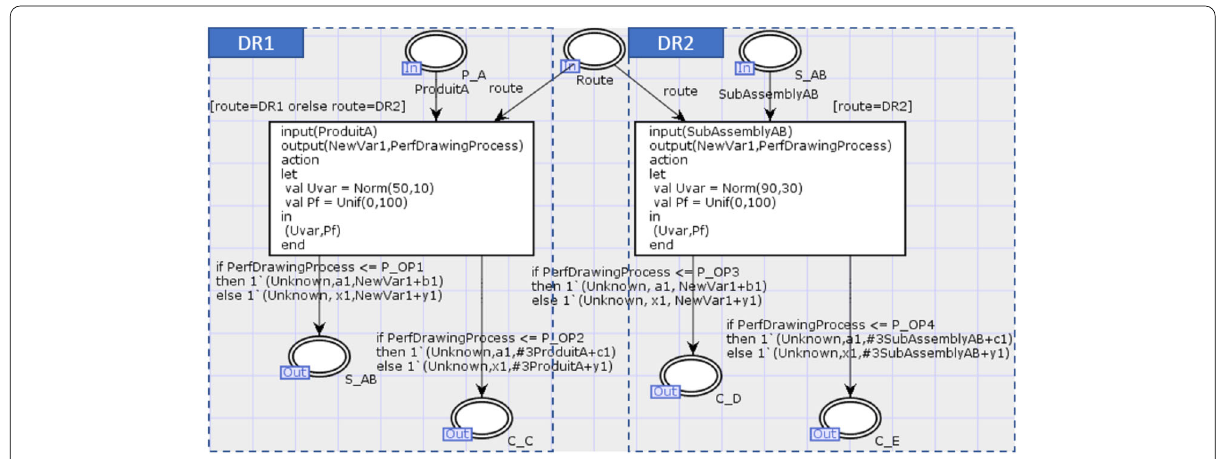
Figure 10 GCSPN for disassembly